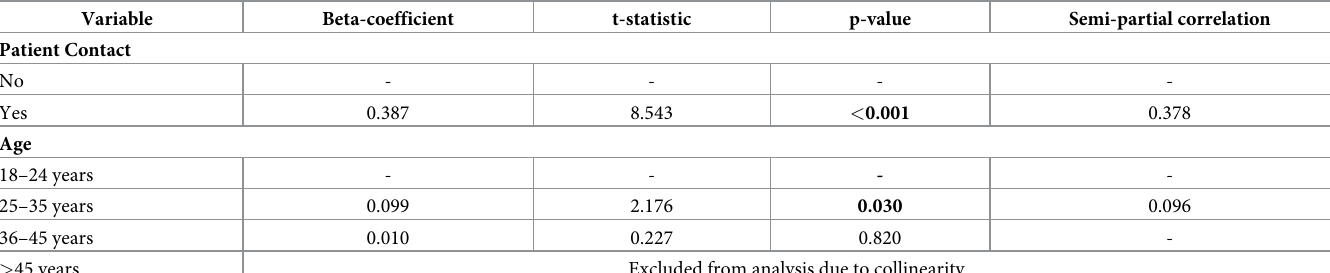
Table 4. Summary of stepwise multiple regression model for preparedness score.